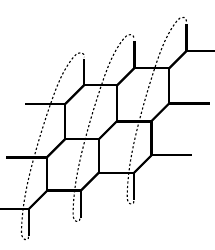
Figure 1 . A compacti(cid:12)ed web diagram which we are considering in the